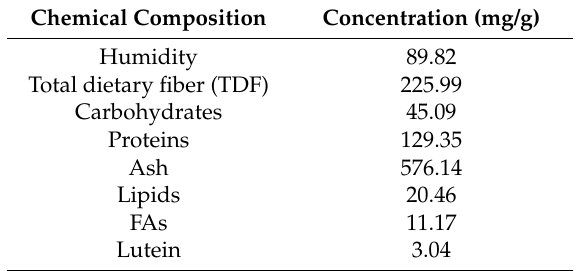
Table 5. Chemical composition of S.